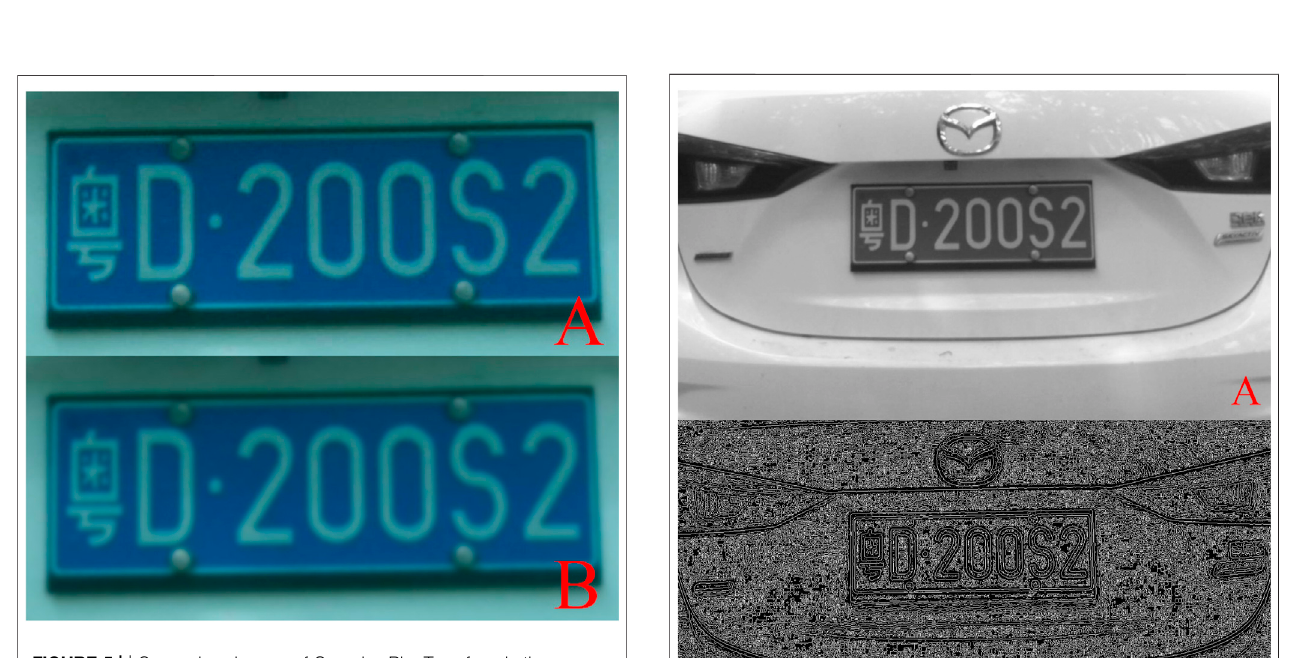
FIGURE 5 | | Comparison images of Gaussian Blur Transform in the license plate area. (A) was the image before transformation, and (B) was the image after transformation.